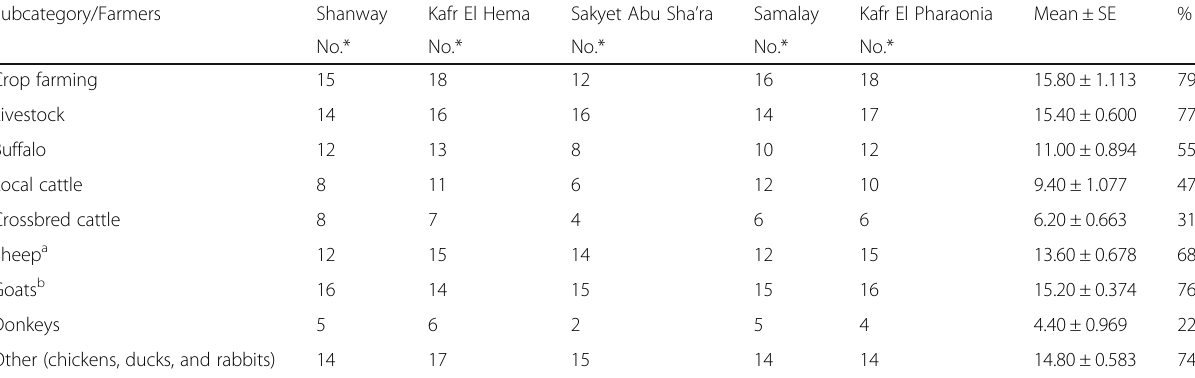
Table 2 Importance of livestock to farmers in rural areas of the Nile Delta in Egypt Subcategory/Farmers